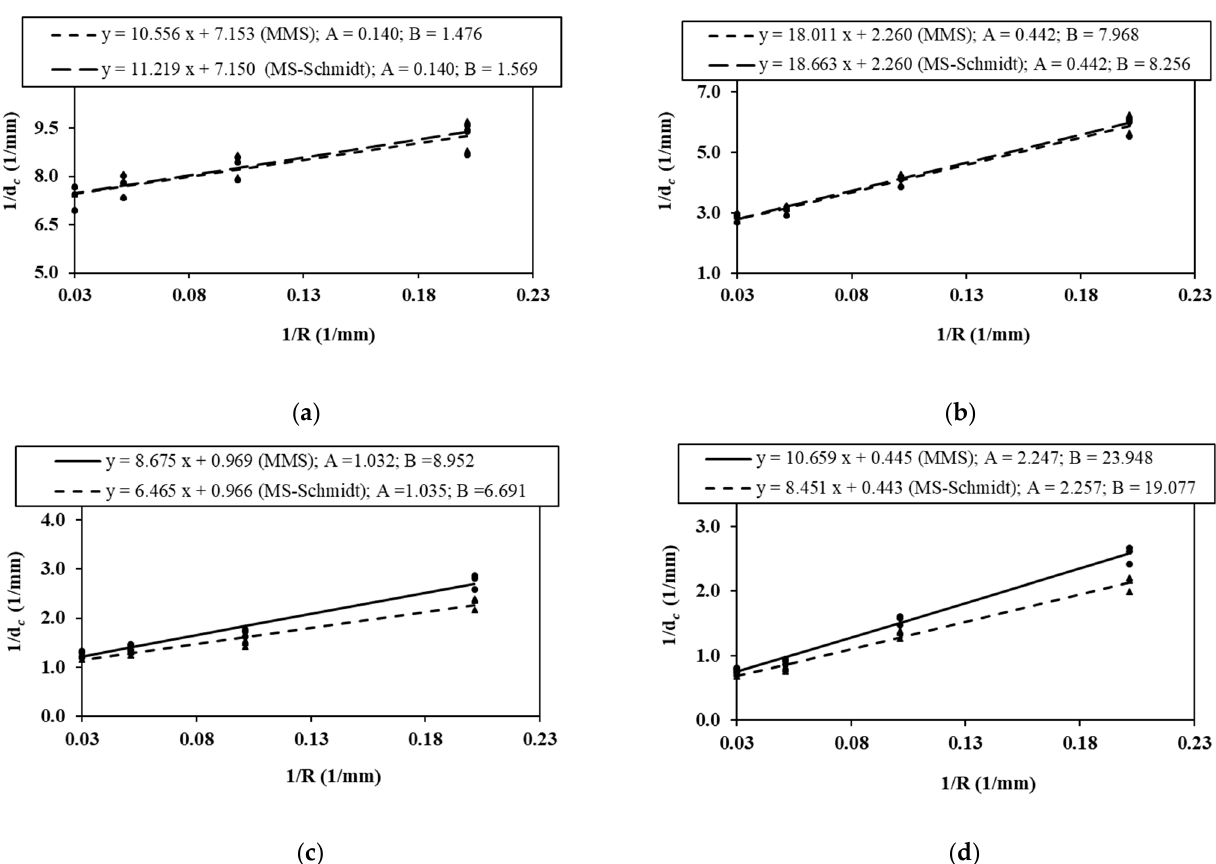
Figure 6. Variations of 1/d c versus 1/R considering both the MS-Schmidt’s and MMS criteria, together with two linear fittings. ( a ) BD specimens made of PMMA; ( b ) BD specimens made of GPPS; ( c ) SCB specimens made of PMMA; ( d ) SCB specimens made of GPPS.